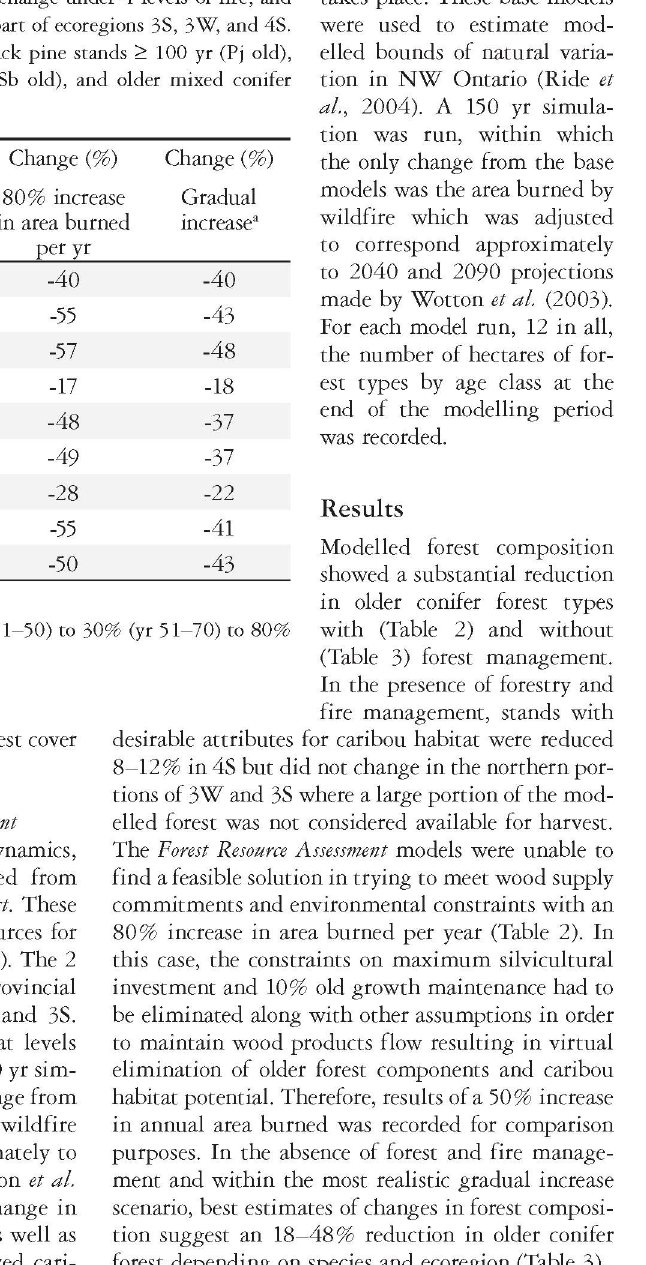
Table 3. Modelled (150 yr) forest composition change under 4 levels of fire, and without forest management on all or part of ecoregions 3S, 3W, and 4S. Forest response is reported for older jack pine stands > 100 yr (Pj old), older black spruce stands > 110 yr (Sb old), and older mixed conifer stands > 110 yr (Conmx